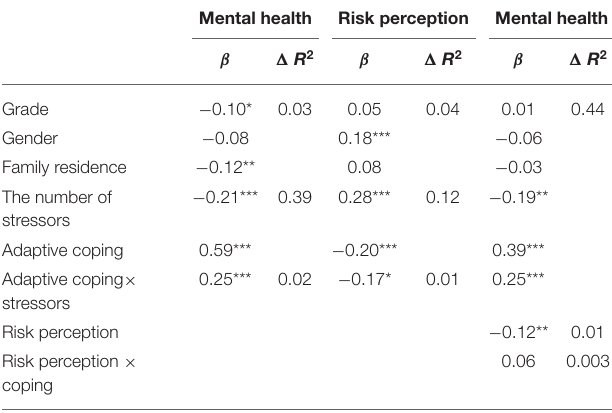
TABLE 2 | Multiple regressions predicting psychological mental health from stressors, risk perception of being infected with disease and coping strategy ( N =